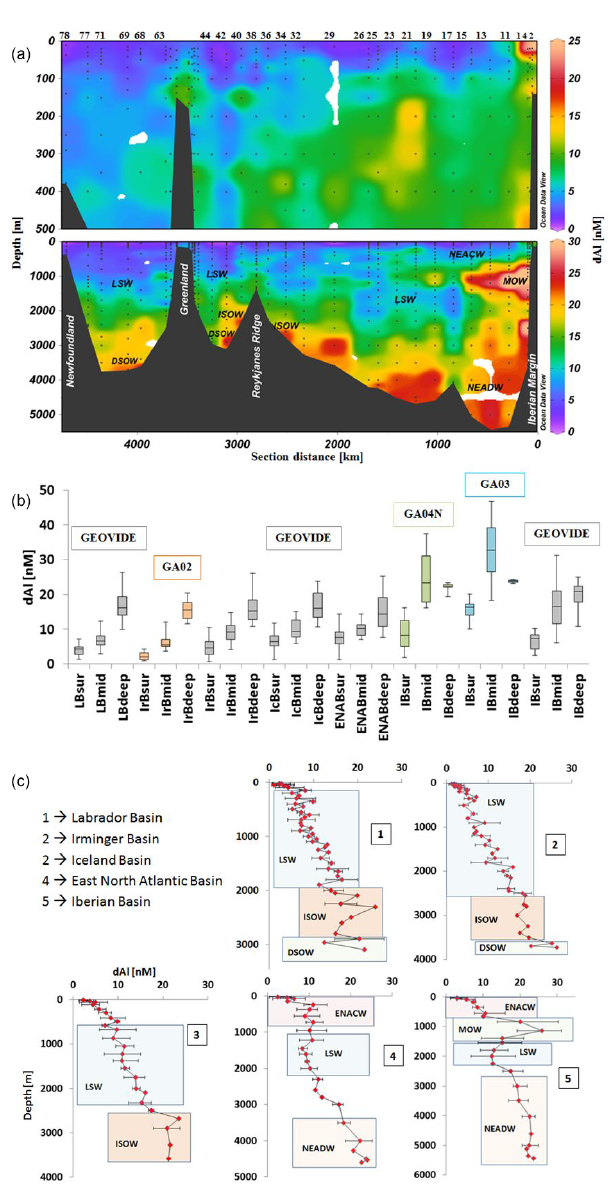
Figure 6. (a) Cross-section plot of dAl concentrations (nM) over the full depth of the water column. Numbers represent the station num- bers. On the Greenland shelf, stations numbers are as follow: from right to left 49, 60, 56, 53, 61, 63, and 64. Discrete sampling depths are indicated by filled black dots. For reference to water masses, please refer to Fig. 1b. (b) Box and whisker plots for the different basins relative to depth. Sur: 50–500m; Mid: 500–2500m; Deep: 2500m–seafloor. Note that for the IrB and LB, sur, mid, and deep stand for 50–300, 300–1500, and 1500m–seafloor as these basins are less deep. Orange, green, and blue boxes are data from GEO- TRACES cruise GA02 (Middag et al., 2015b), GA04N (Rolison et al., 2015), and GA03 (Measures et al., 2015), respectively. (c) Av- erage dAl depth profiles (see Sect. 3.1 for stations).